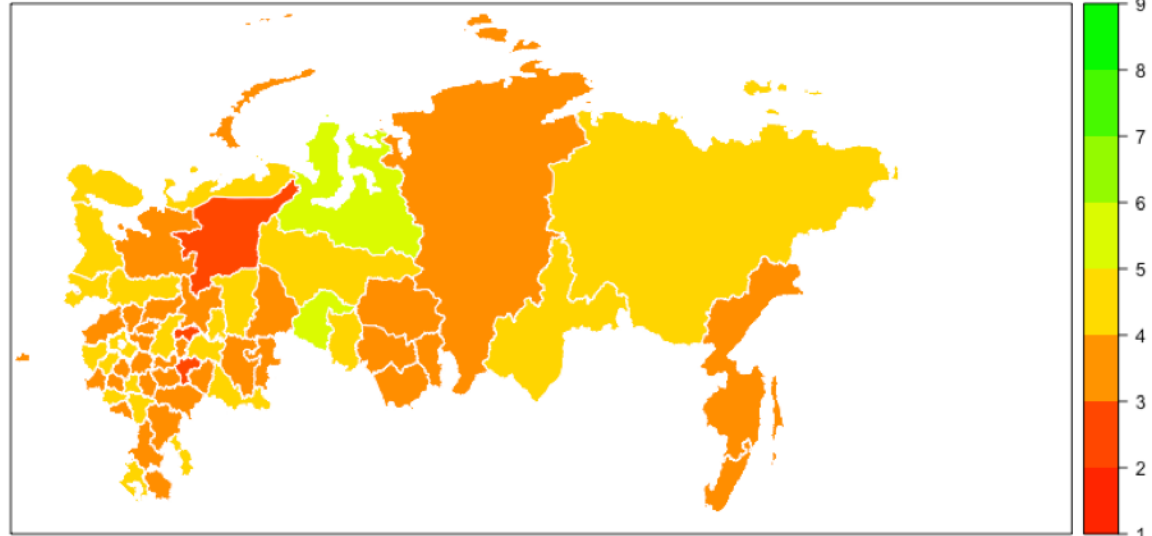
Figure 6. Map of Russia showing the levels of respondents’trust to state and local authorities, and country readiness for the pandemic. Areas with data from less than 40 respondents are not shown on the map. The combined median score on trust to state and local authorities, and country readiness for the pandemic (Question [Q]4. I think the country I am responding from is well prepared for COVID-19; Q5. I think all possible government measures to fight COVID-19 are being taken in my country; Q6. I think that all possible local authority measures to fight COVID-19 are being taken in my city/town/village/etc; Q7. I trust the government in the country I am responding from; Q8. I trust the local authorities in the city/town/village/etc I am responding from). Respondents were provided with a 9-point Likert scale, where 1 is completely disagree and 9 is completely